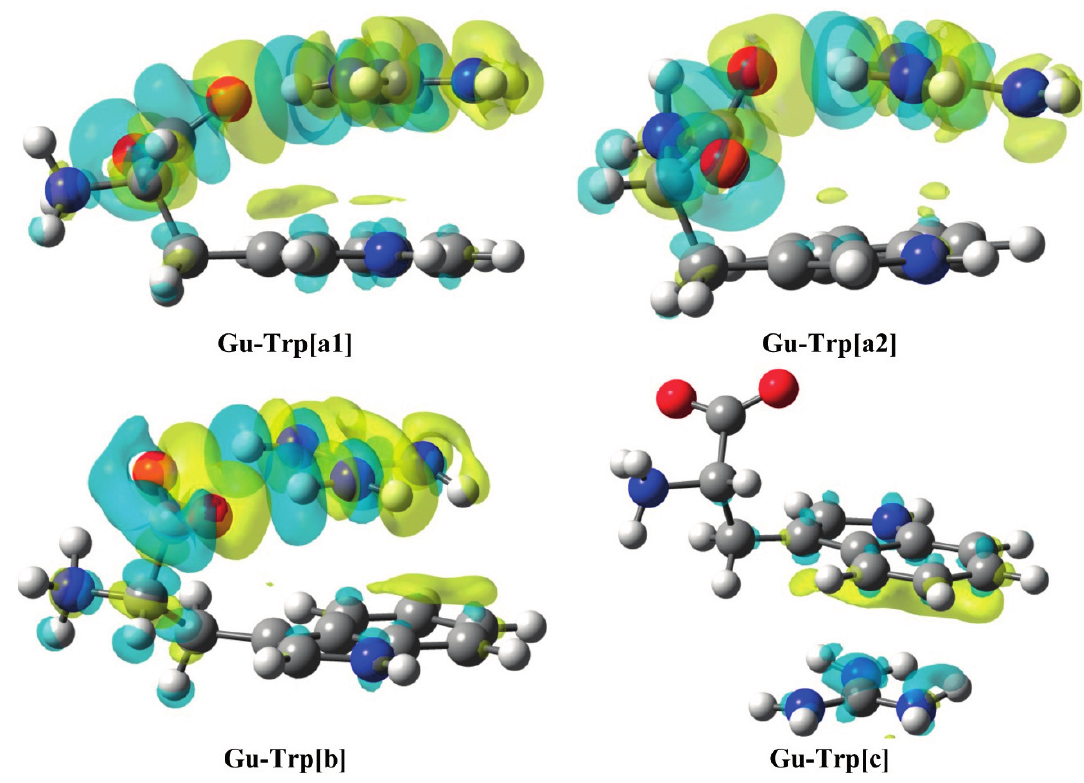
Figure 3. Electron Density Shifts at 0.00045 a.u. of Gu-Tyr complexes at the M06-2X/6-311++G(d,p) computational level in PCM–water. Yellow and blue areas represent positive (increase) and negative (decrease) electron density regions